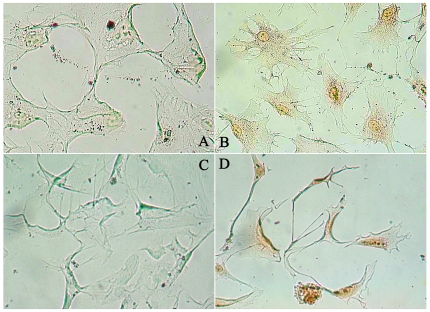
TUNEL detection of apoptosis in BMECs and BACs with and without A. cantonesis larvae extracts.No positive signal was detected in (A) BMECs cultured alone or (C) BACs cultured alone. After the addition with larvae extract, positive signals were observed in both (B) BMECs and (D) BACs. This figure shows a representative example of three independent experiments that all gave similar results.